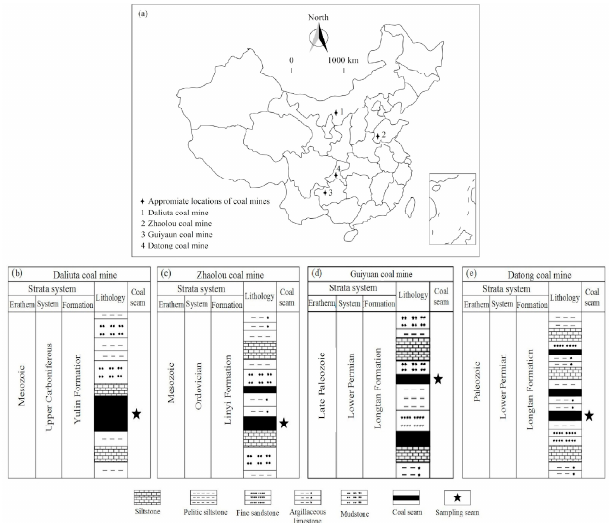
Figure 1. The information of the sampling coal mines: ( a ) location, and ( b–e ) stratigraphic column. Table 1. Proximate and ultimate analyzes of the coal samples.